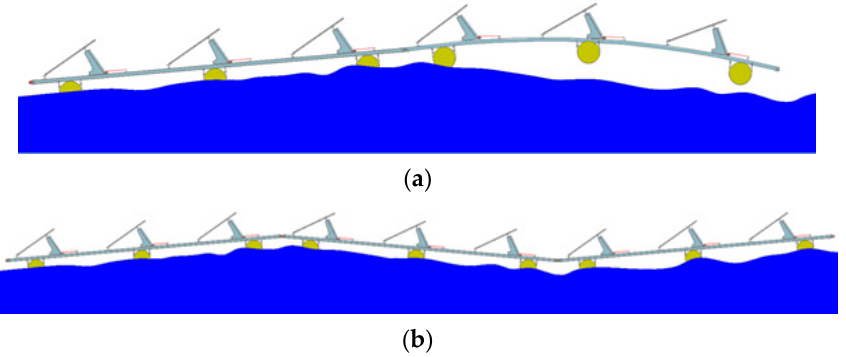
Figure 2. Behavior of the floating structure. ( a ) Continuous structural members; ( b ) discontinuous structural members.